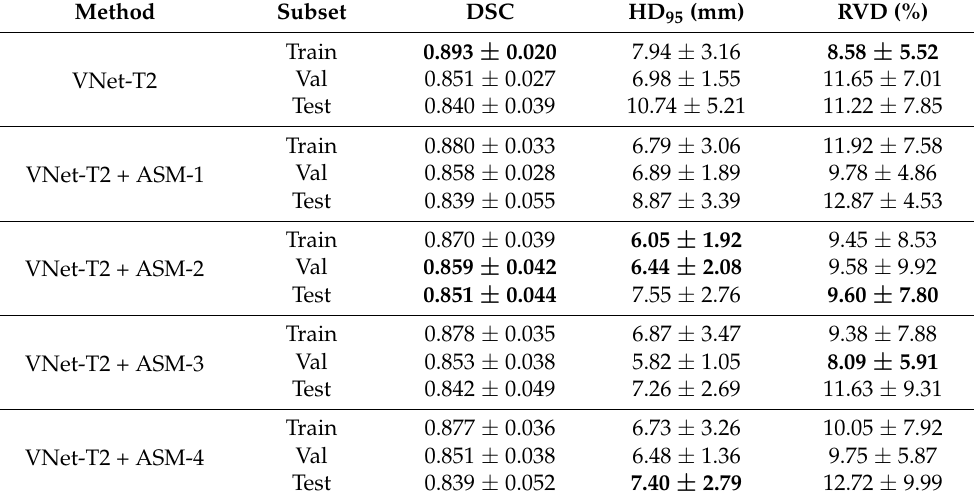
Table 4. Performance of the proposed strategy on train, validation and test sets. VNet-3D indicates the result of the segmentation by adopting only the 3D network described in Section 2.3. VNet-3D + ASM indicates the combination of the 3D network with the 4 configurations of the ASM. Best values are highlighted in bold. HD 95 : 95th percentile Hausdorff distance; RVD: relative volume